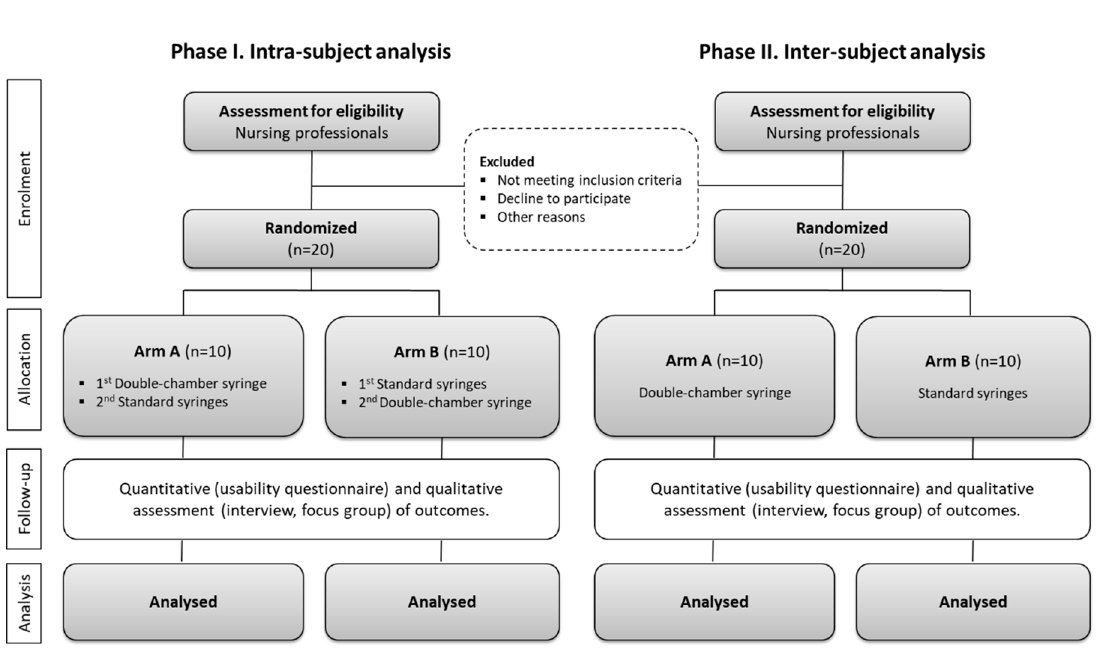
Figure 1. Flowchart of the two-arm parallel randomized controlled trial (RCT).